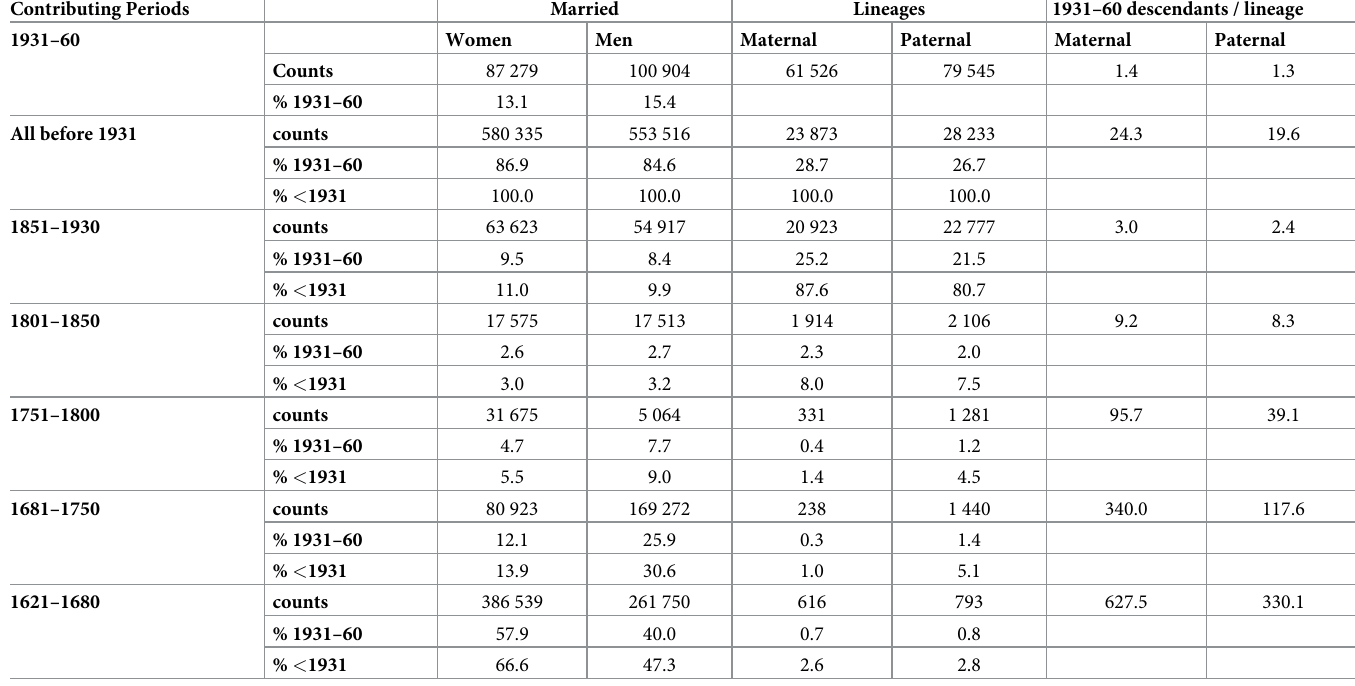
Table 2. Contribution of immigrants from different periods to the 1931–60 Que´bec, both in the number of their married descendants and in the number of distinct maternal and paternal